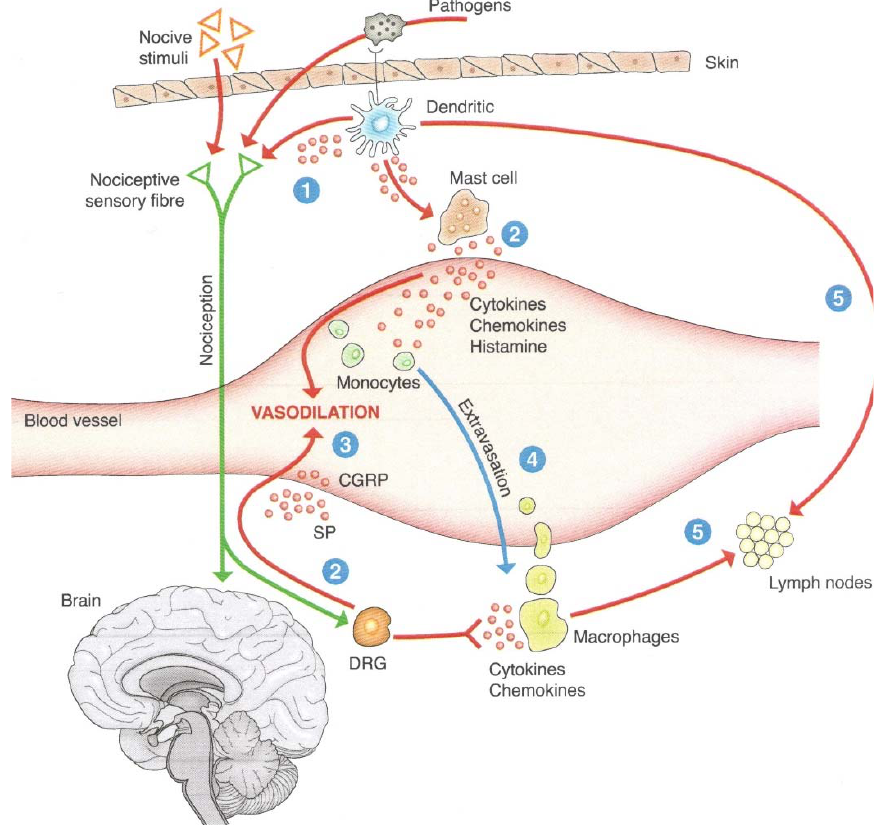
Figure 2. The cooperation between sensory nerves and immune cells. The figure shows (1) the shared capacity that sensory nerves and immune cells have to receive signals from pathogens, orchestrating a joint response. The sensory nerves will, on the one hand, send a pain signal to the brain (nociception) and, on the other hand (2), via the dorsal root ganglion (DRG) of the spinal cord, will produce neuropeptides (substance P (SP) and calcitonin gene-related peptide (CGRP)) that react on the blood vessel, causing vasodilation and inflammation. The same phenomena are produced by mast cell degranulation (3) with the release of inflammation mediators, including histamine. Vasodilation and the presence of cytokines and chemokines cause the circulating monocytes to be called upon, which, due to modifications of the vasal endothelium in the meantime, will be able to escape the vessel (4) by entering the tissue (represented by the skin in the figure), where they will be activated against pathogens. Finally, the activated macrophages and, in particular, dendritic cells will migrate towards the lymph nodes (5), presenting the antigen to helper T cells, completing the immune response. Source: Reprinted with permission from Ref. [2]. 2020, Edra.